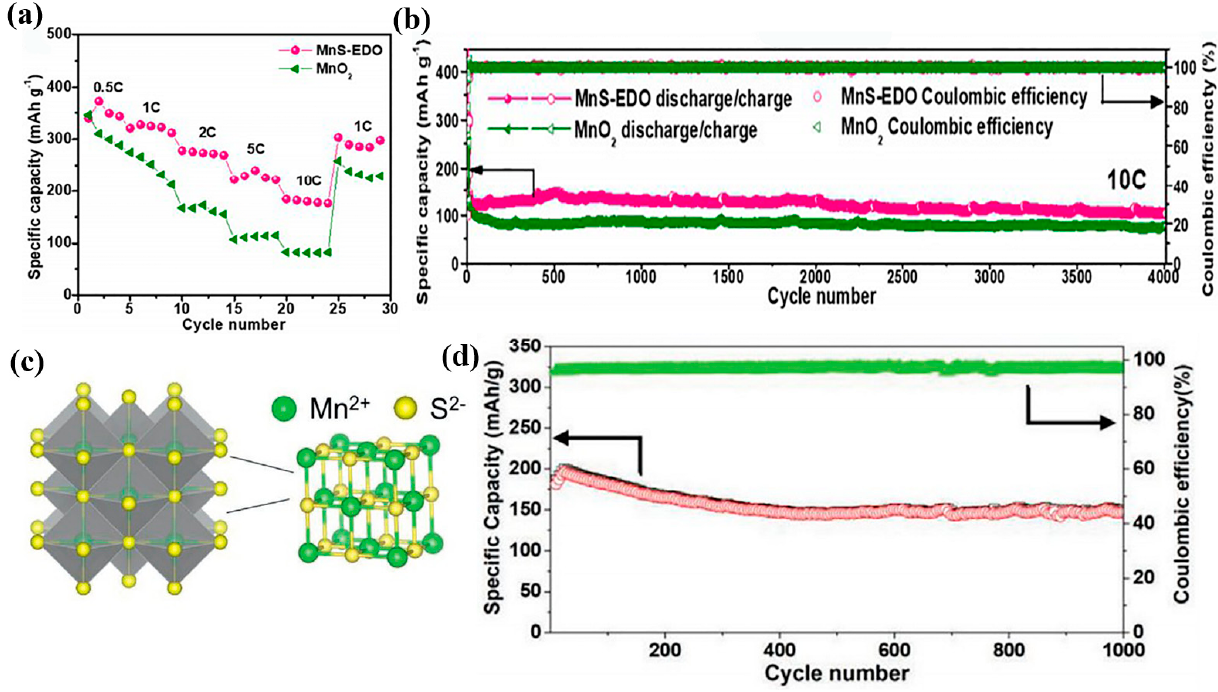
Figure 5. The long-term cycle performance of MnS electrodes. ( a ) Rate capability of the two elec- trode. ( b ) The long-term cycling at 10 C. Reproduced with permission [56]. Copyright 2020, Else- vier Ltd. ( c ) Crystal structure model of α -MnS; ( d ) Cyclic stability in 2 M ZnSO 4 and 0.1 M MnSO 4 aqueous electrolyte. Reproduced with permission [58]. Copyright 2021, Wiley-VCH GmbH.